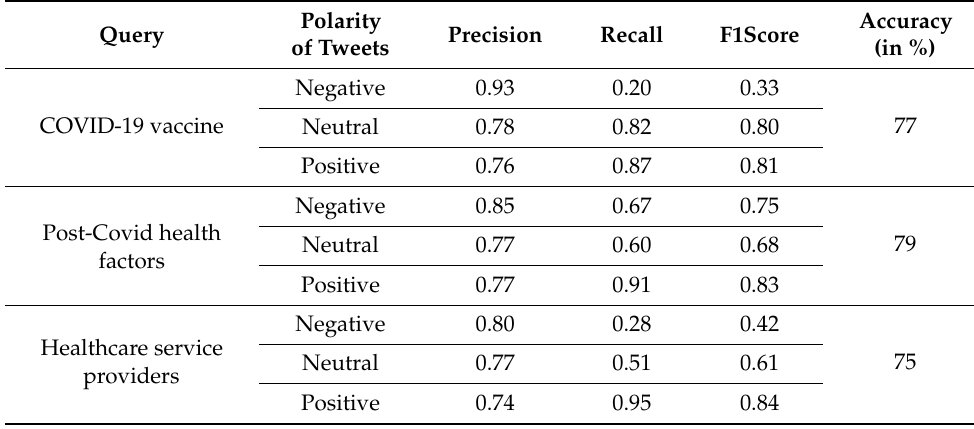
Table 6. Random forest model evaluation results for all three considered queries.